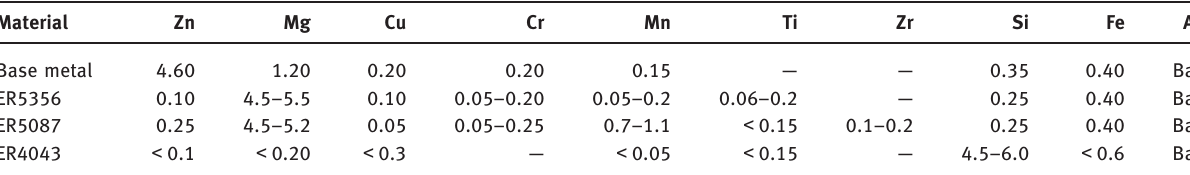
Table 1: Chemical composition of base metal and welding wire (wt% ). Material